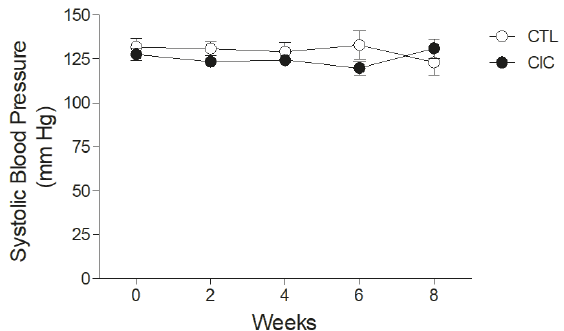
Figure 3. Systolic blood pressure from CTL and CIC groups during the experimental period. Data are expressed as mean ± S.E.M. (CTL, n = 11; CIC, n = 17), analyzed by Unpaired Student t